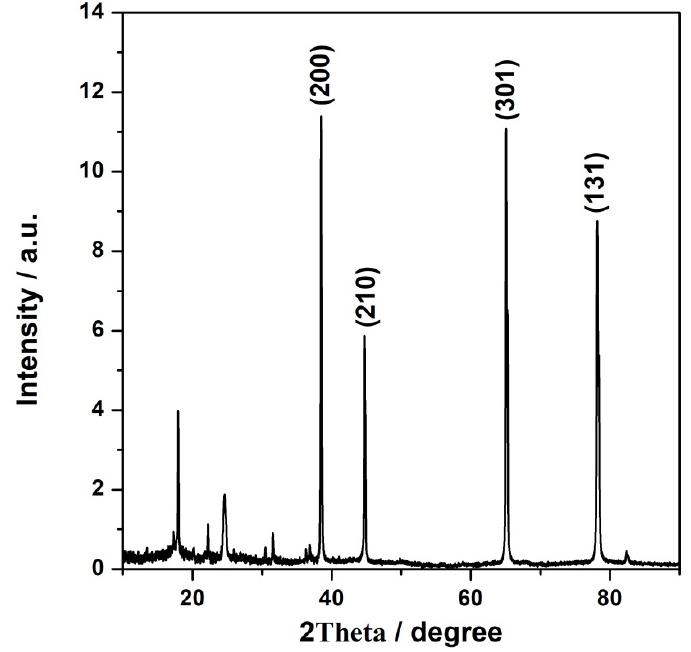
Figure 1. X-ray diffraction patterns for the CFeN@rGO-COOH electrocatalysts.